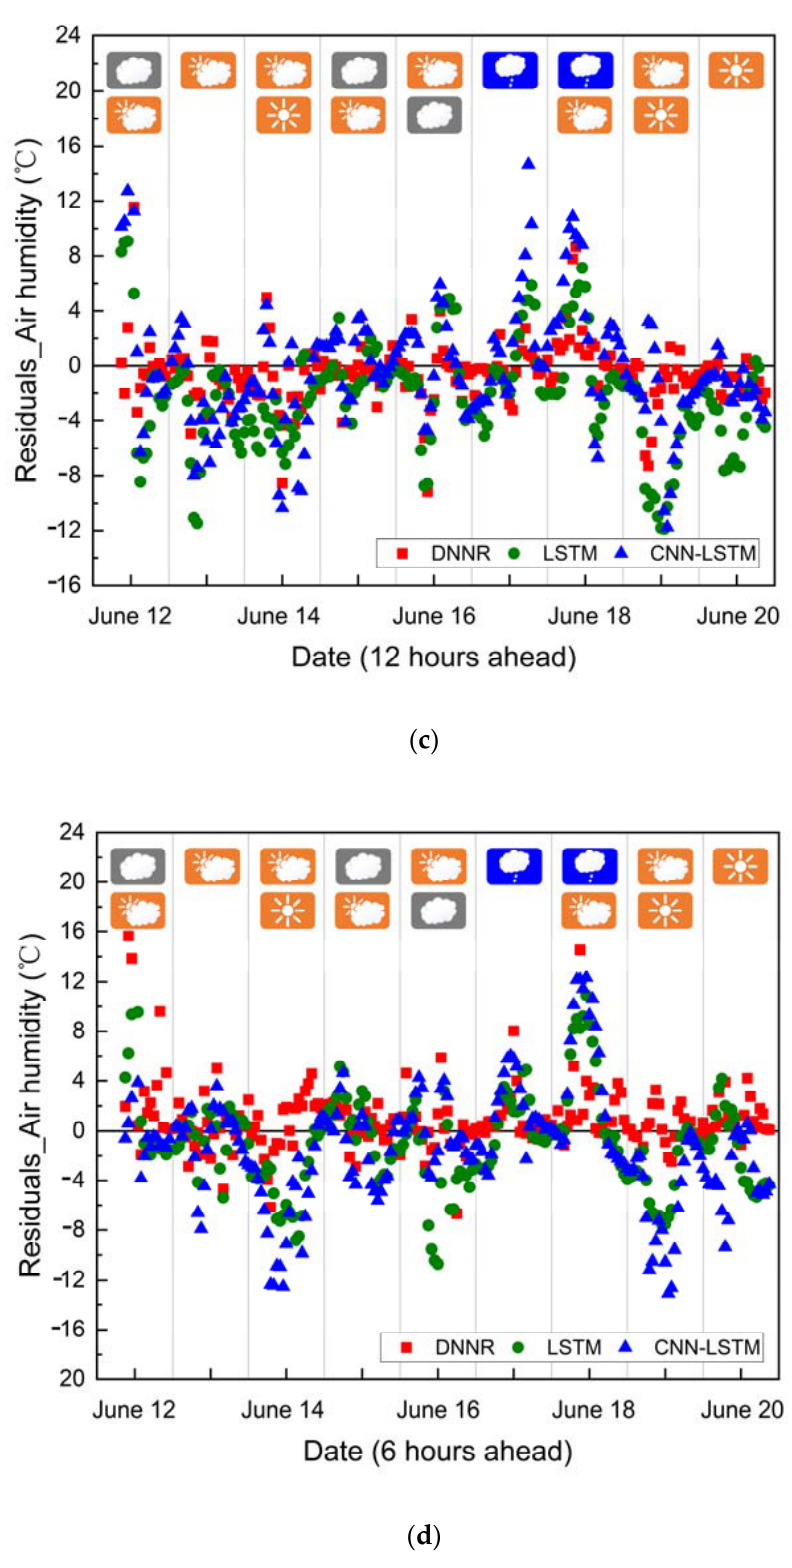
Figure 20. The ST of the three model errors for Greenhouse B temperature under different weather conditions; ( a ) 3 h advance, ( b ) 6 h advance, ( c ) 12 h advance, ( d ) 24 h advance. The degree of dispersion between the predictive value and the actual value of air humidity was larger than the degree of dispersion between the predictive value and the actual value of air temperature in two greenhouses, this was due to the greenhouse where the range of air humidity value was greater than the range of air temperature value.